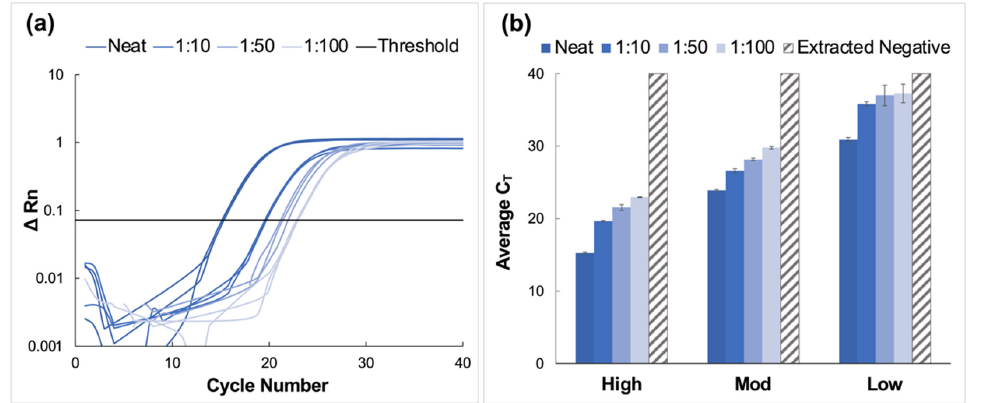
Figure 4. Amplification data obtained from pooling experiments using saliva samples collected using the CRL OMNIgene ® • ORAL sampling kit. ( a ) A representative normalized amplification plot obtained from RT-PCR analysis of extracted RNA (high viral titer). ( b ) Summary of CT data. Dilution ratios increase from left to right ( n = 3). It was determined using Tukey’s test that the average CT values for the high viral titer dilutions were statistically distinct from each other ( p < 0.0001). This was also true for the moderate viral titer pools ( p < 0.0001). However, for low viral titer dilutions, it was determined that there was no statistical difference between means when the 1:50 dilu- tions were compared to those diluted to 1:100 ( p > 0.9999). For all other dilutions, statistical differ- ences were significant ( p < 0.0001 for neat vs. all dilutions, and p = 0.0285 and 0.0243 for 1:10 vs. 1:50 and 1:100 dilutions, respectively.